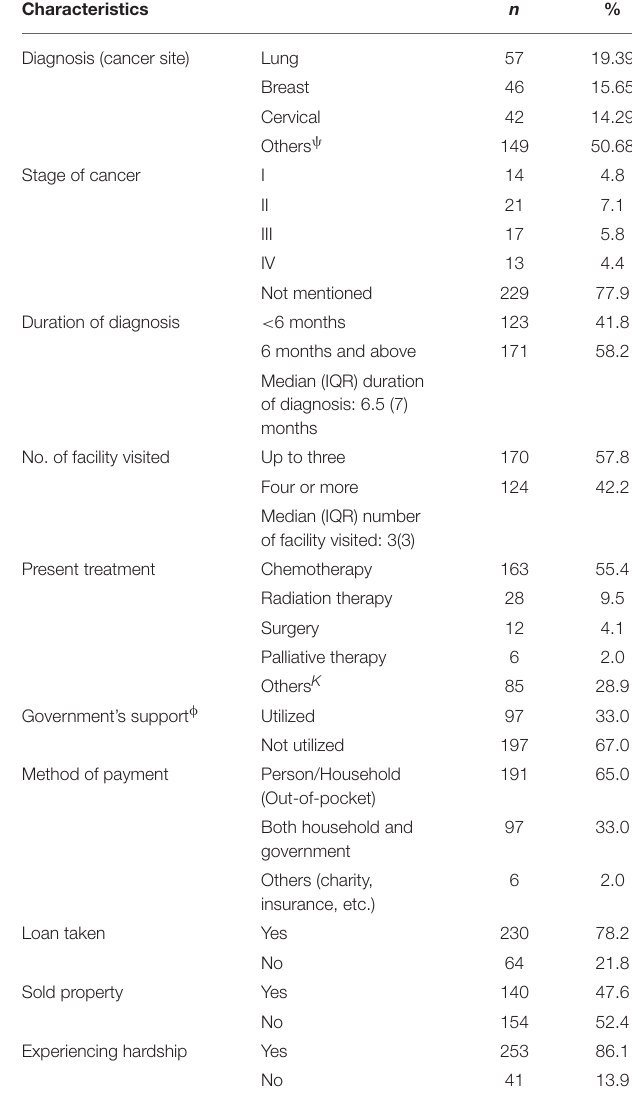
ψ Other cancers: Gastrointestinal (related to stomach, intestine, GB, Liver) 42 (14.3%),